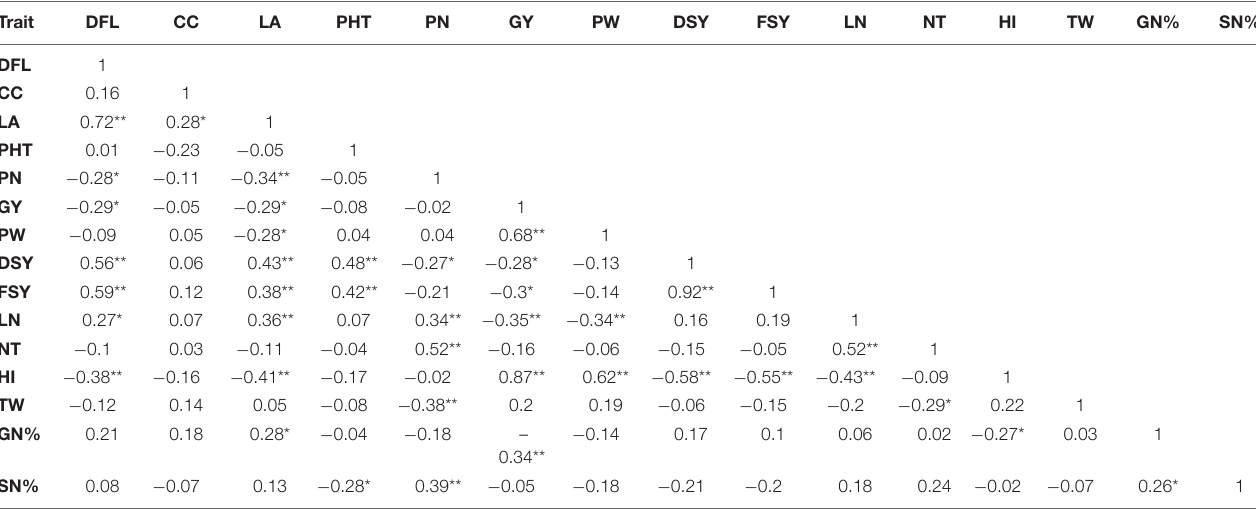
TABLE 3 | Correlation coefficient analysis of 60 genotypes for different traits at N0 condition across seasons. Trait